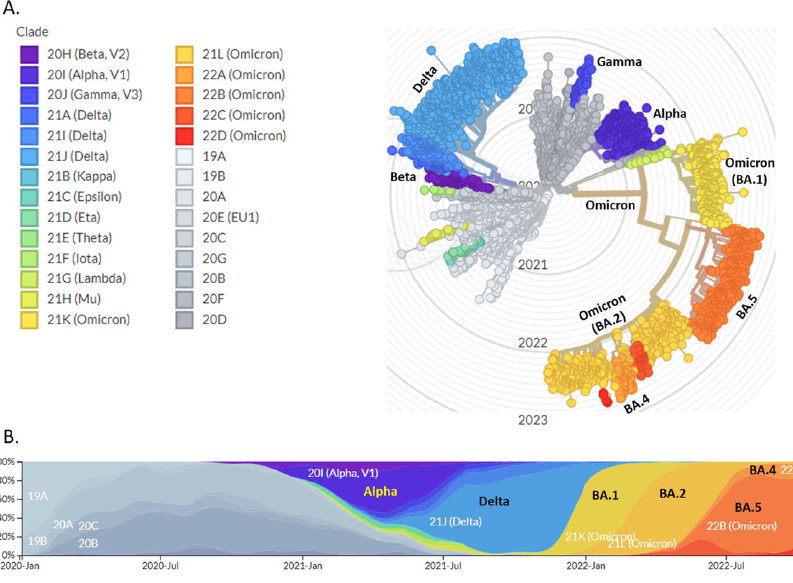
Figure 1. ( A ) A time-resolved maximum likelihood phylogeny of a representative global subsample of 3004 SARS-CoV-2 complete genomes sampled between December 2019 and October 2022 from the GISAID. The variants of concern (VOCs) are denoted by different colour schemes. The figure was generated by the Nextstrain using the data from the GISAID, ( B ) The global distribution frequencies of VOCs are denoted by different colour schemes over the timespan since SARS-CoV-2’s emergence.